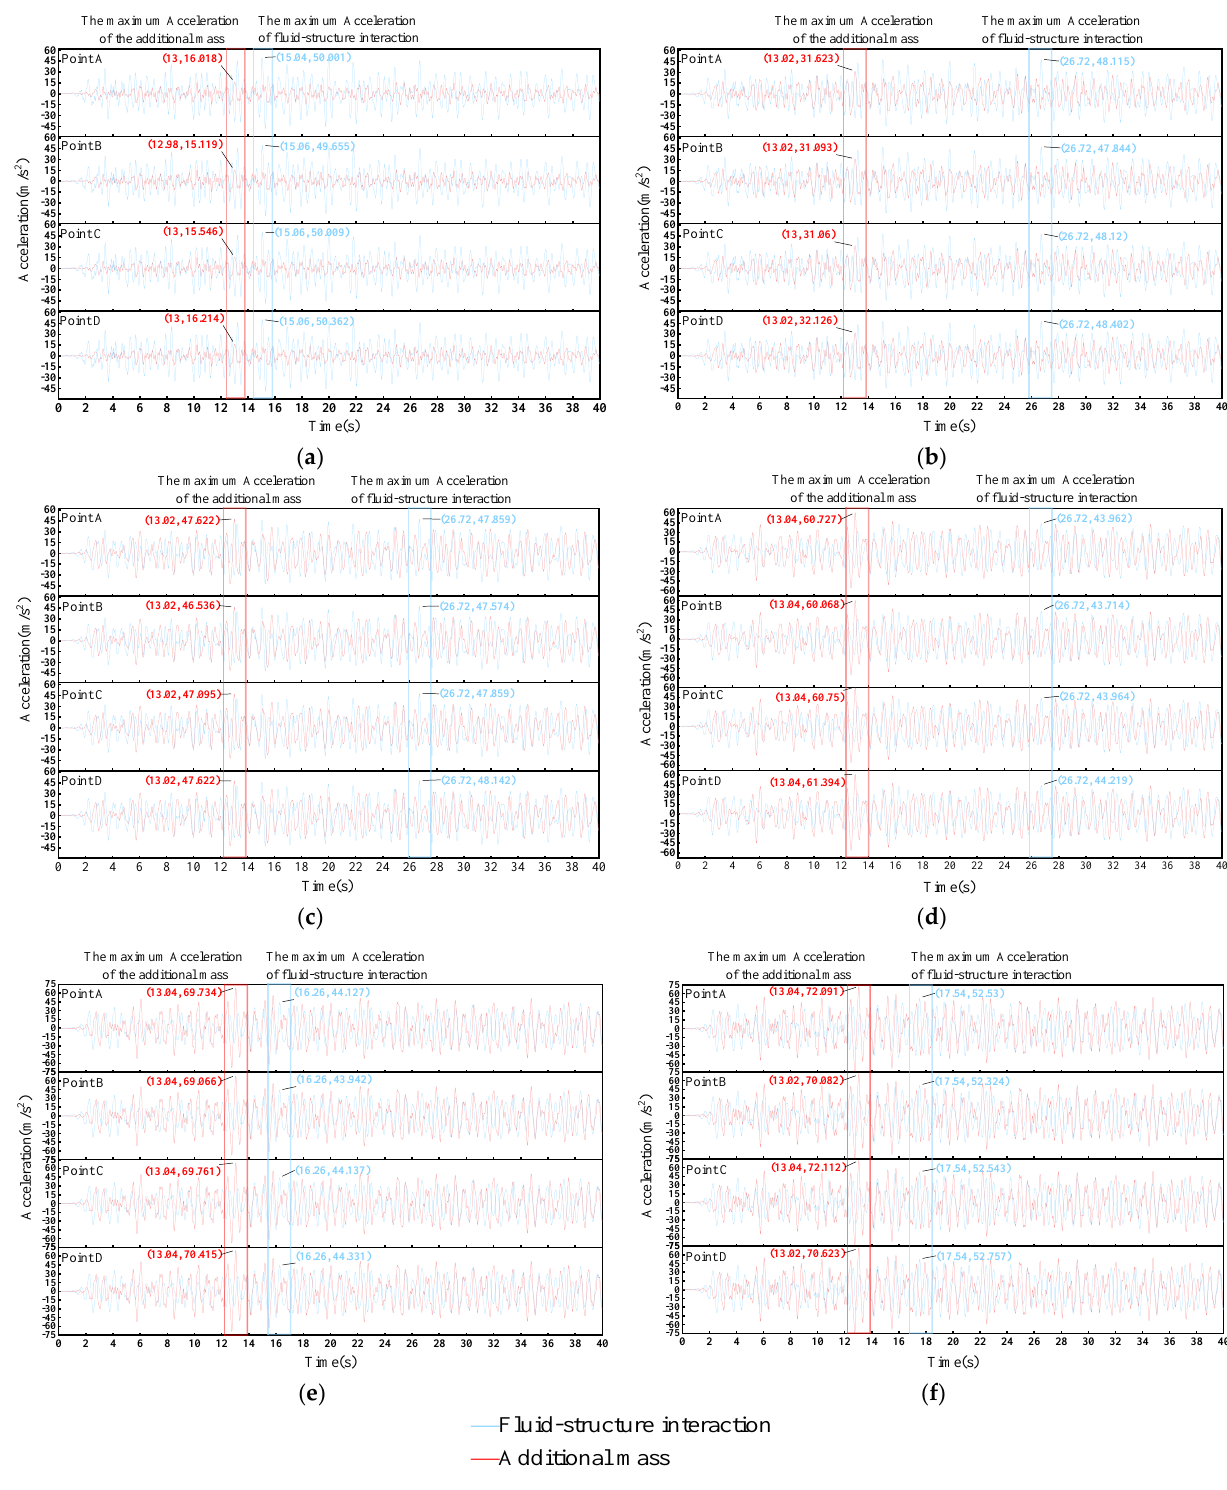
Figure 14. Seismic acceleration response ( a ) Pipeline cross-section 1 acceleration response time history curve; ( b ) pipeline cross-section 2 acceleration response time history curve; ( c ) pipeline cross-section 3 acceleration response time history curve; ( d ) pipeline cross-section 4 acceleration response time history curve; ( e ) pipeline cross-section 5 acceleration response time history curve; ( f ) pipeline cross-section 6 acceleration response time history curve.